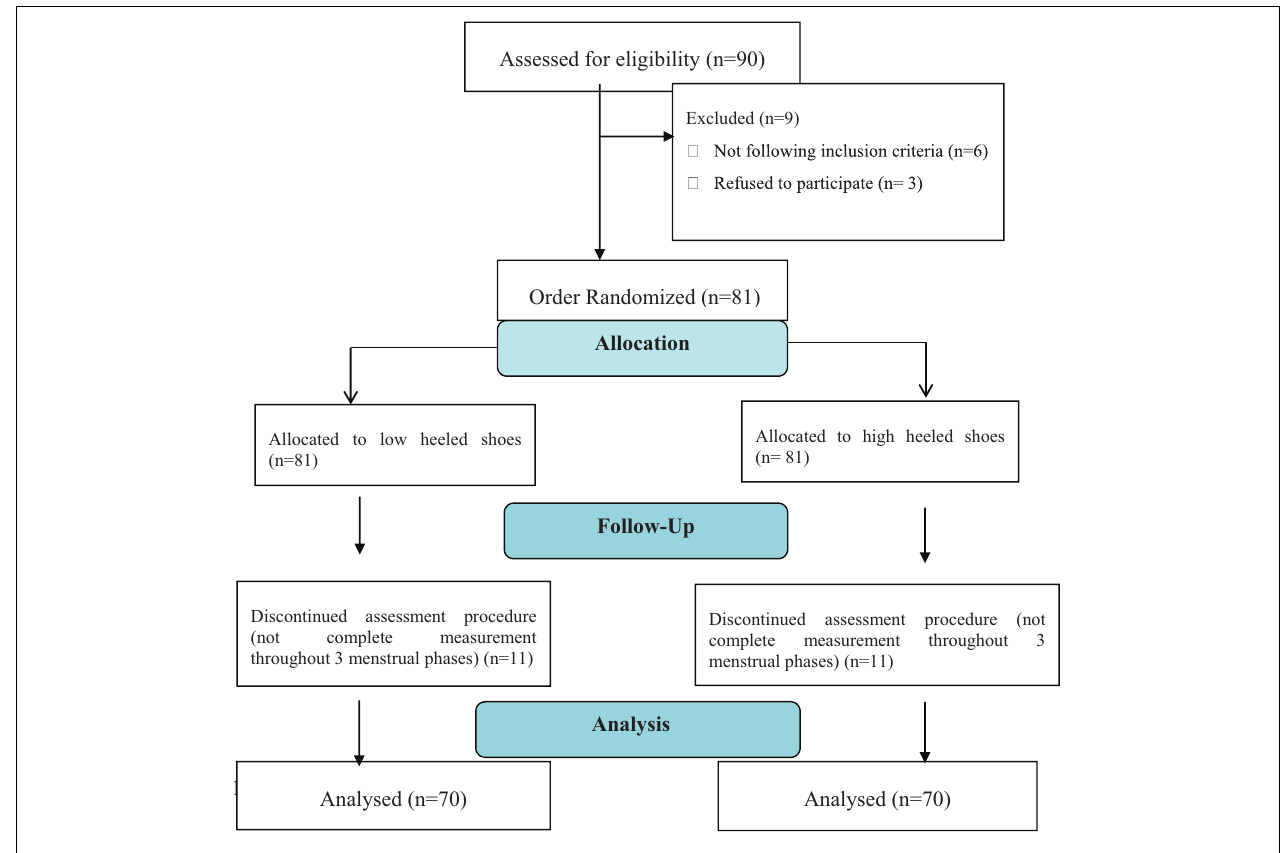
FIGURE 3 | Flow diagram of this